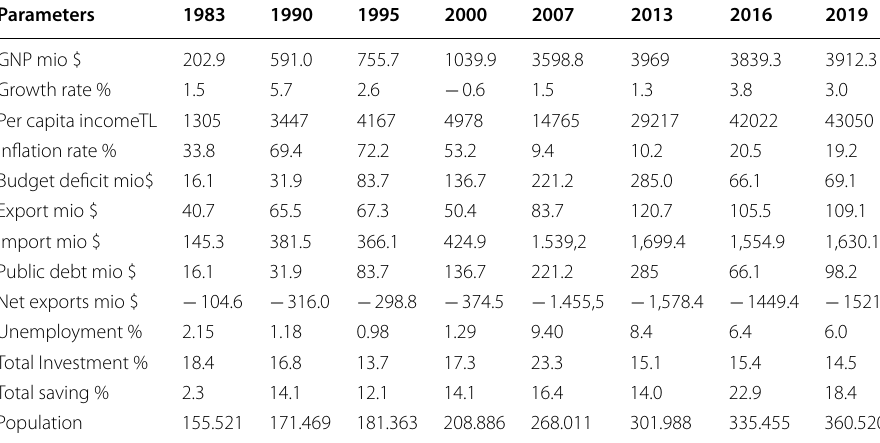
Table 1 Economic and social indicators for Northern Cyprus. Source : http:// www. devpl an. org/ Frame- tr. html (in main economic and social indicators) Parameters